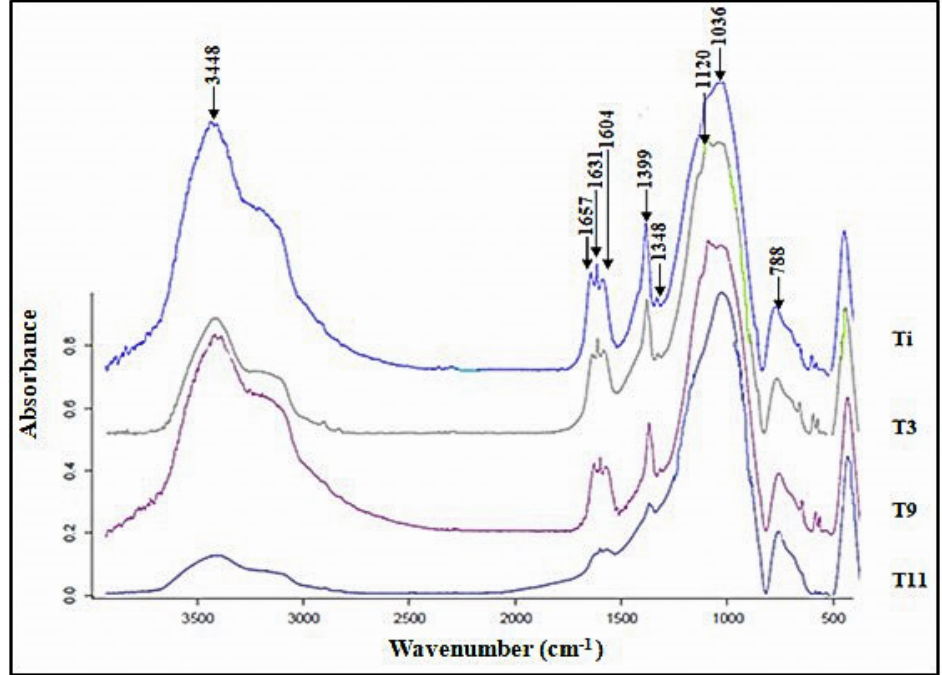
Figure 2. Infrared spectra indicating the evolution of compost samples at various stages of compost- ing (T3: 3rd month, T9: 9th month and T11: 11th month).